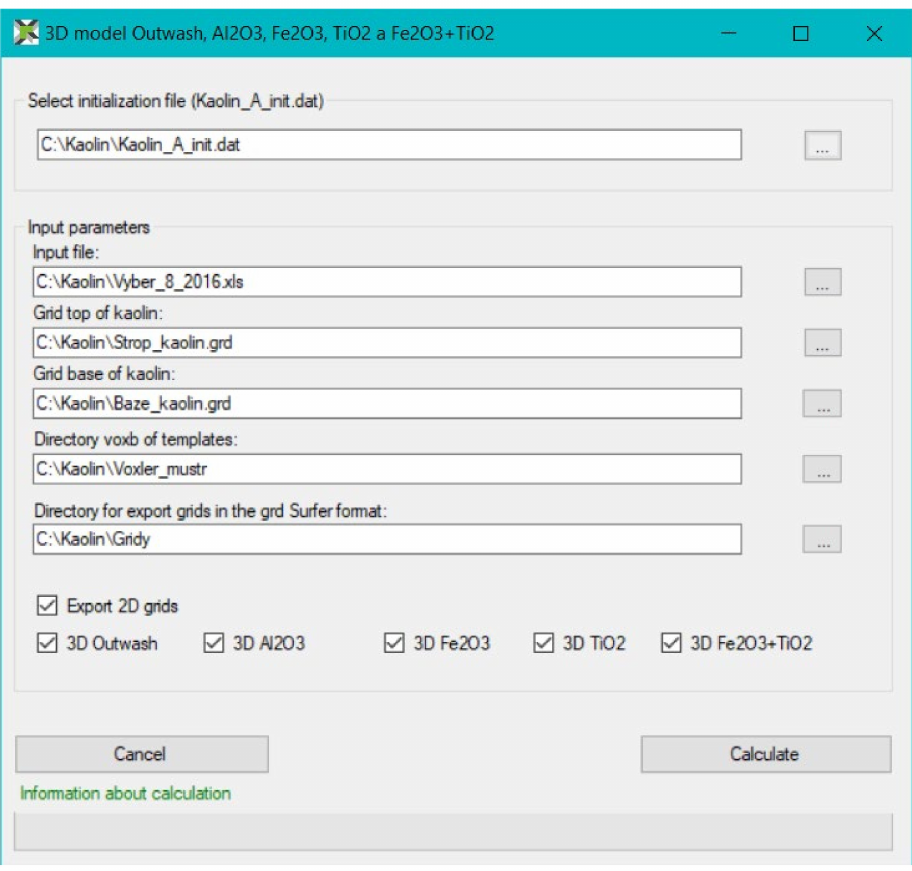
Figure 8. Window of program Kaolin_A for setting the calculation parameters.